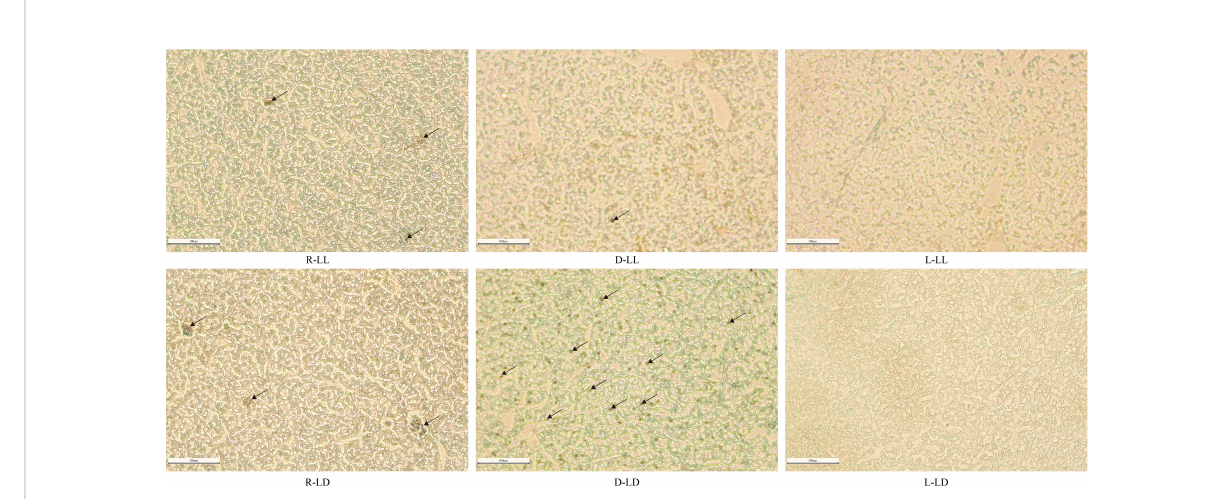
FIGURE 9 TUNEL staining analysis of liver in juvenile Oncorhynchus mykiss under different experimental treatments (200 × magni fi cation, scale bars = 100 m m, slice thickness = 7 m m). R: random feeding, D: mid-dark stage feeding, L: mid-light stage feeding, LL: 24L: 0D, LD: 12L: 12D. The black arrows point to apoptotic